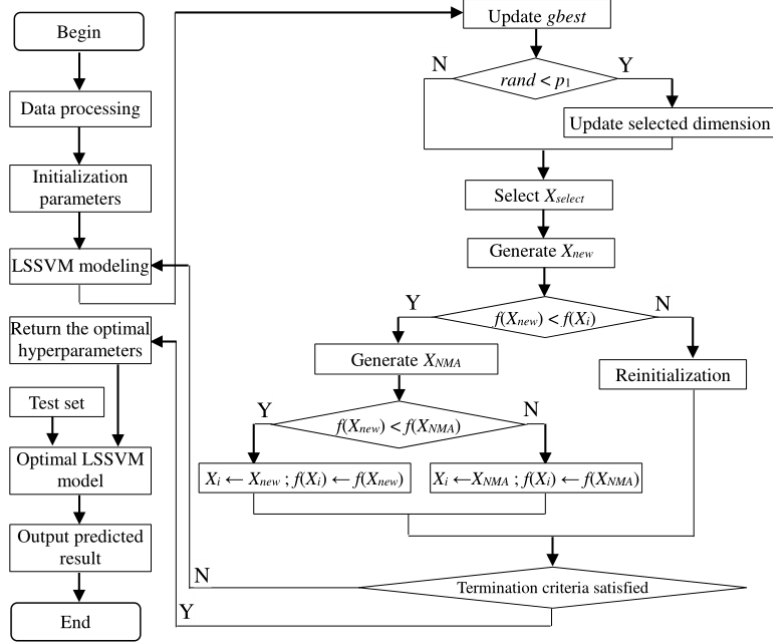
Figure 12. Flow chart of the BSONME-LSSVM model.